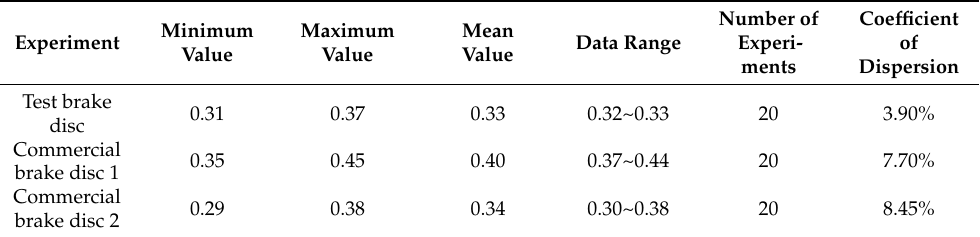
Table 4. Distributions of the friction coefficient measurements of the three C/C brake discs (based on data from the first 20 tests at the design landing